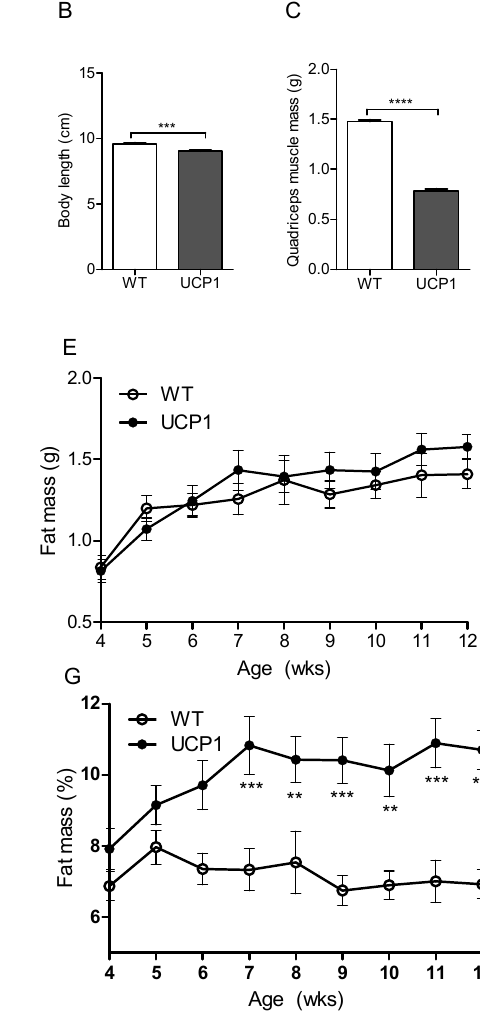
Figure 1. Morphometric data of female mice overexpressing UCP1 in skeletal muscle (UCP1-TG; UCP1) and wild-type (WT) littermate controls, both fed chow diets for 12 weeks. Body weight development ( A ), body length at week 12 of age ( B ), quadriceps weight at the age of 12 weeks ( C ), lean body mass development ( D ), body fat mass development ( E ), lean body mass as percentage of body mass ( F ) body fat mass as percentage of body mass ( G ) were determined. Statistical analyses were carried out based on 8 mice per group, except for body length and quadriceps weight ( n = 10). Data are expressed as mean +/ − SEM; ( A , D , E , F , G ): two-way ANOVA; ( B , C ): Student’s t-test; * p < 0.05, ** p < 0.01, *** p < 0.001, **** p < 0.0001.